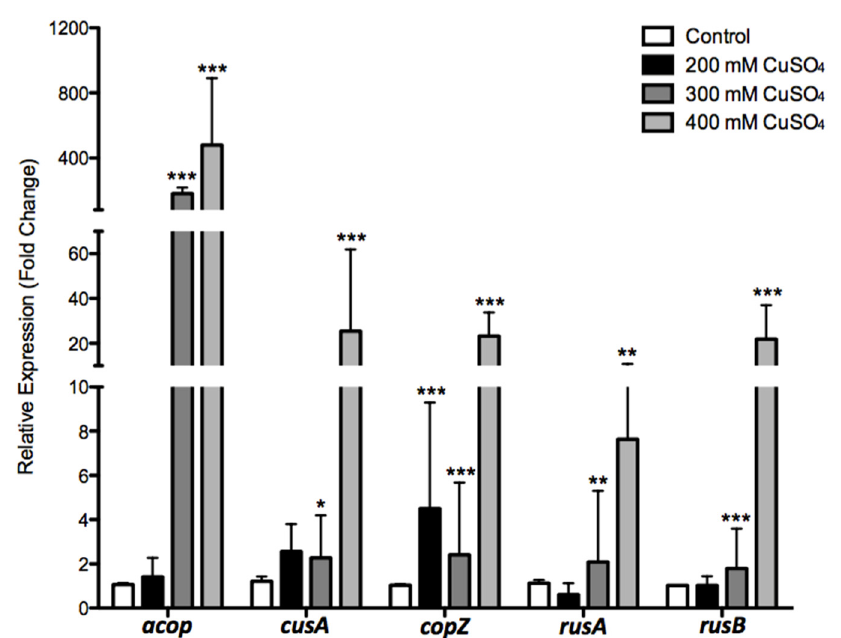
Figure 7. Gene relative expression of A. ferrivorans ACH selected genes, involved in copper resistance. The cells were grown in ferrous iron with the addition of three different concentrations of CuSO 4 200, 300, and 400 mM (grey to black bars are copper conditions and white bars are control conditions). Error bars indicate standard deviations based on three different experimental values. Applications of Student’s t -test were as follows: *** p ≤ 0.001, ** p ≤ 0.01, and * p ≤ 0.05.